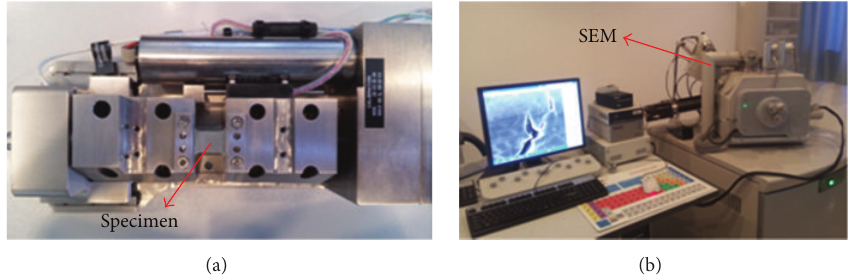
Figure 2: Experimental platform: (a) in situ testing stage. (b) Quanta 650 SEM.